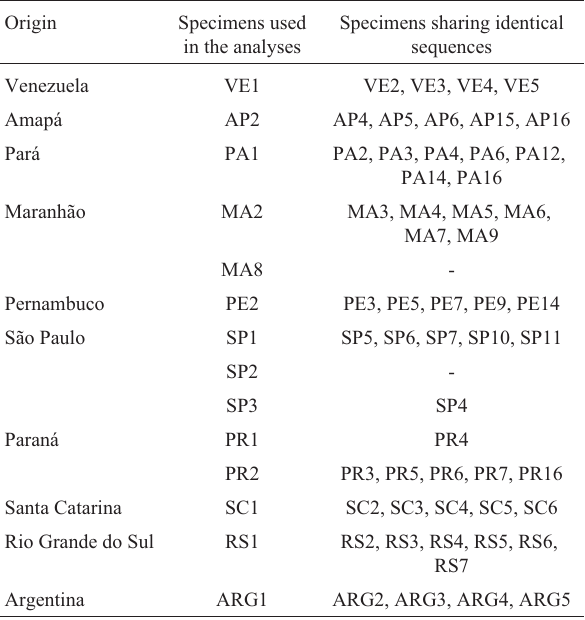
Table 3 - Specimens of Macrodon ancylodon whose 16S rRNA was analyzed.